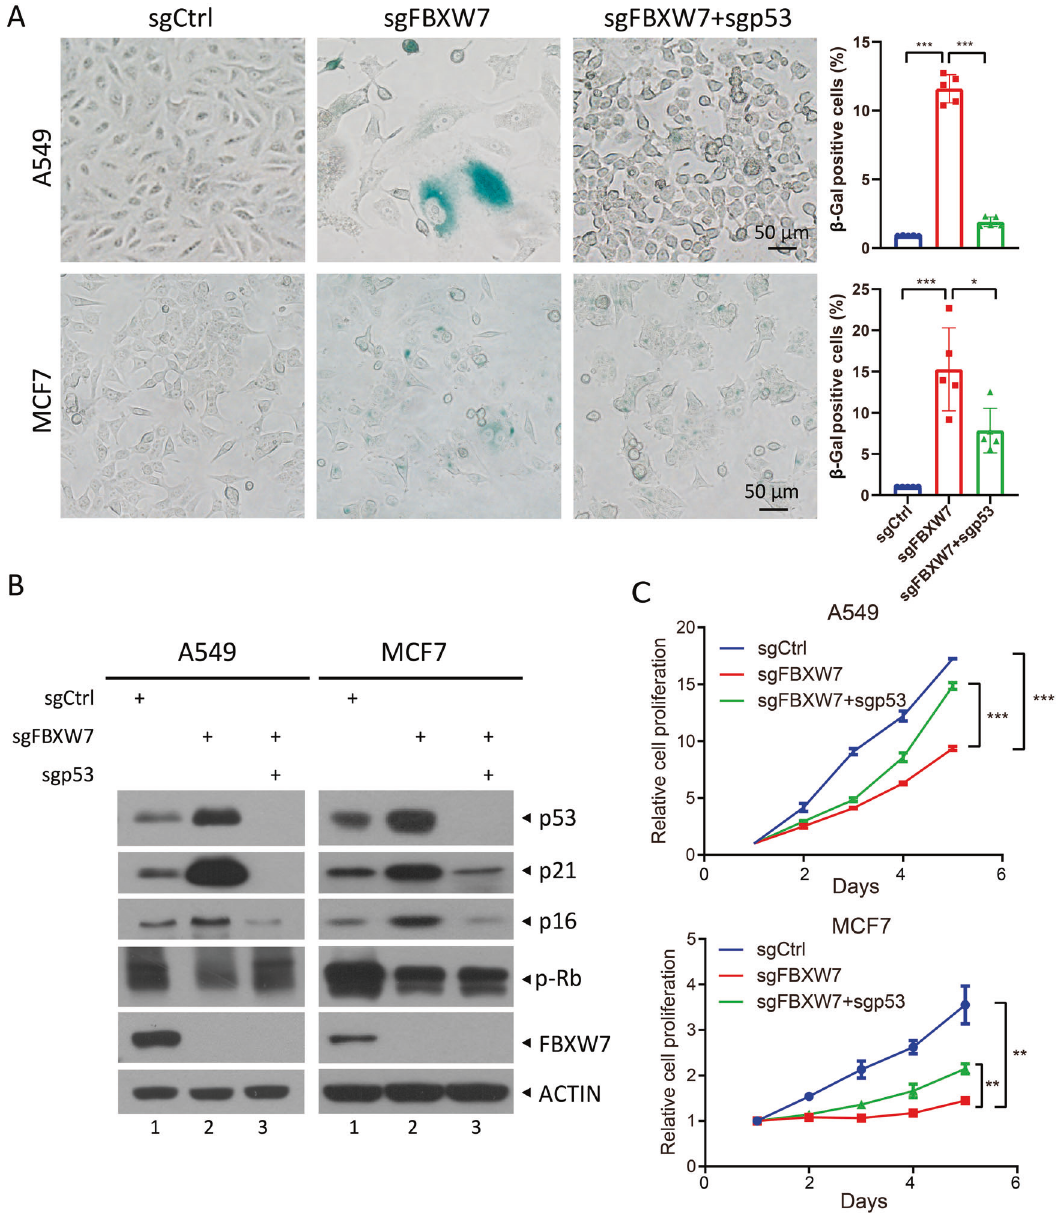
Fig. 2 Simultaneous p53 deletion abrogates cell senescence induced by FBXW7 deletion. A549 and MCF7 cells with deletion of the indicated genes using CRISPR/Cas9 technology were subjected to SA- β -Gal staining, followed by microscopy ( A left) or IB with the indicated antibodies ( B ), or cell counting kit (CCK)-8-based cell proliferation assay ( C ). The percentage of SA- β -Gal-positive cells in the total number of cells was determined ( A right). Scale bars represent 50 μ m. Data are presented as the mean ± SD. * p < 0.05, *** p < 0.001. Cell proliferation is expressed as a fold-change compared to day 1. Data are presented as the mean ± standard error of the mean (SEM) from three independent experiments. n = 3; ** p < 0.01, *** p <